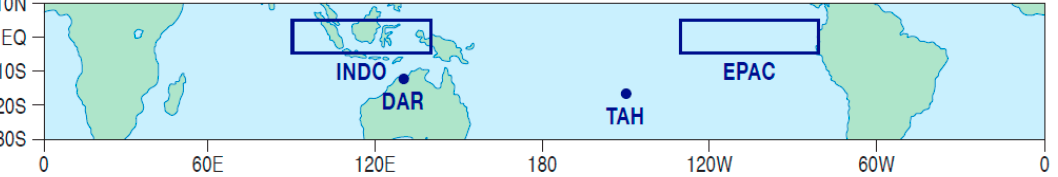
Figure 2. Locations for calculation of SOI and Equatorial SOI. EQ is equator, DAR is Darwin, TAH is Tahiti, EPAC is eastern Pacific and INDO is Indonesia. Sourced and redrawn from Barnston [21] https://www.climate.gov/news-features/blogs/enso/why-are-there-so-many-enso-indexes-instead-just-one.